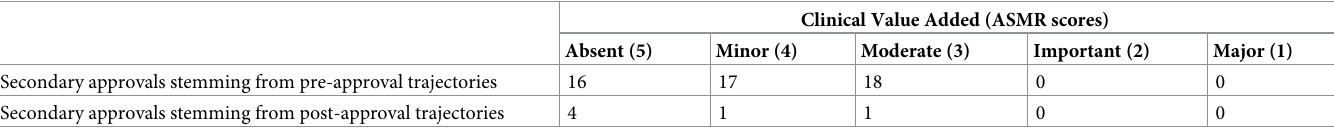
Table 2. The clinical value added of secondary approvals resulting from pre-approval and post-approval